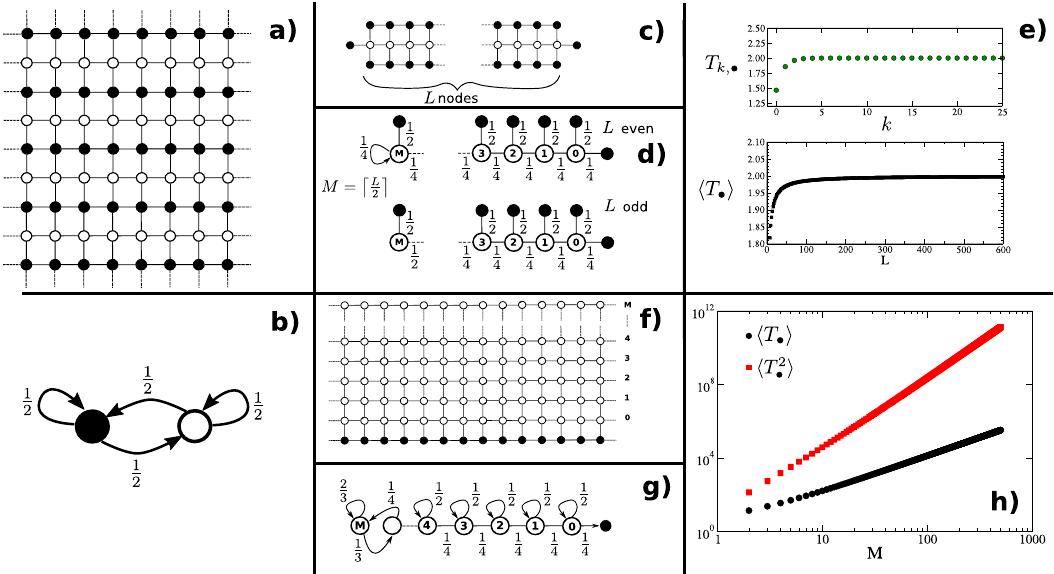
Fig. 3 Characterisation of colour distributions in simple geometries through class mean fi rst passage times (CMFPT). a Two-colour geometry where the nodes of an in fi nite lattice are organised in rows of alternate colours. Its equivalent minimal graph ( b ) contains only two nodes with symmetric connections. c Two-colour geometry where a chain of L nodes of class ∘ is surrounded by (cid:129) nodes. The corresponding minimal associated graph is shown in d and is equivalent to a comb graph (the two cases of even and odd values of L are reported for clarity). e The CMFPT T k , (cid:129) of a ∘ node in the comb graph is a function of its distance k from the endpoint, and converges to 2 as k increases . Similarly, the average CMFPT to (cid:129) (denoted as 〈 T (cid:129) 〉 ) converges to 2 when the length L of the chain increases. f Two-colour geometry consisting of an in fi nite cylinder with M + 1 rows of ∘ nodes, connected to a row of (cid:129) nodes. Its minimal graph ( g ) reduces to a chain with M + 1 ∘ nodes and one (cid:129) node. h We show the fi rst two moments of T k , (cid:129) in an in fi nite cylinder, as a function of the height of the